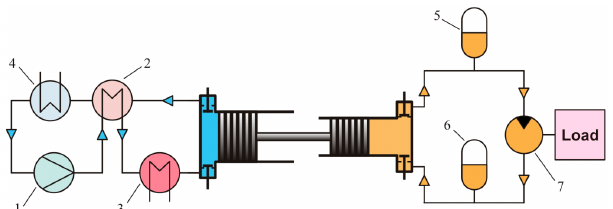
Figure 2. Scheme of a Worthington pump-based power plant producing shaft power. 1 —feed water pump, 2 —heat recuperator, 3 —evaporator, 4 —condenser, 5 —high-pressure hydraulic accumulator, 6 —low-pressure hydraulic accumulator, 7 —hydraulic motor.